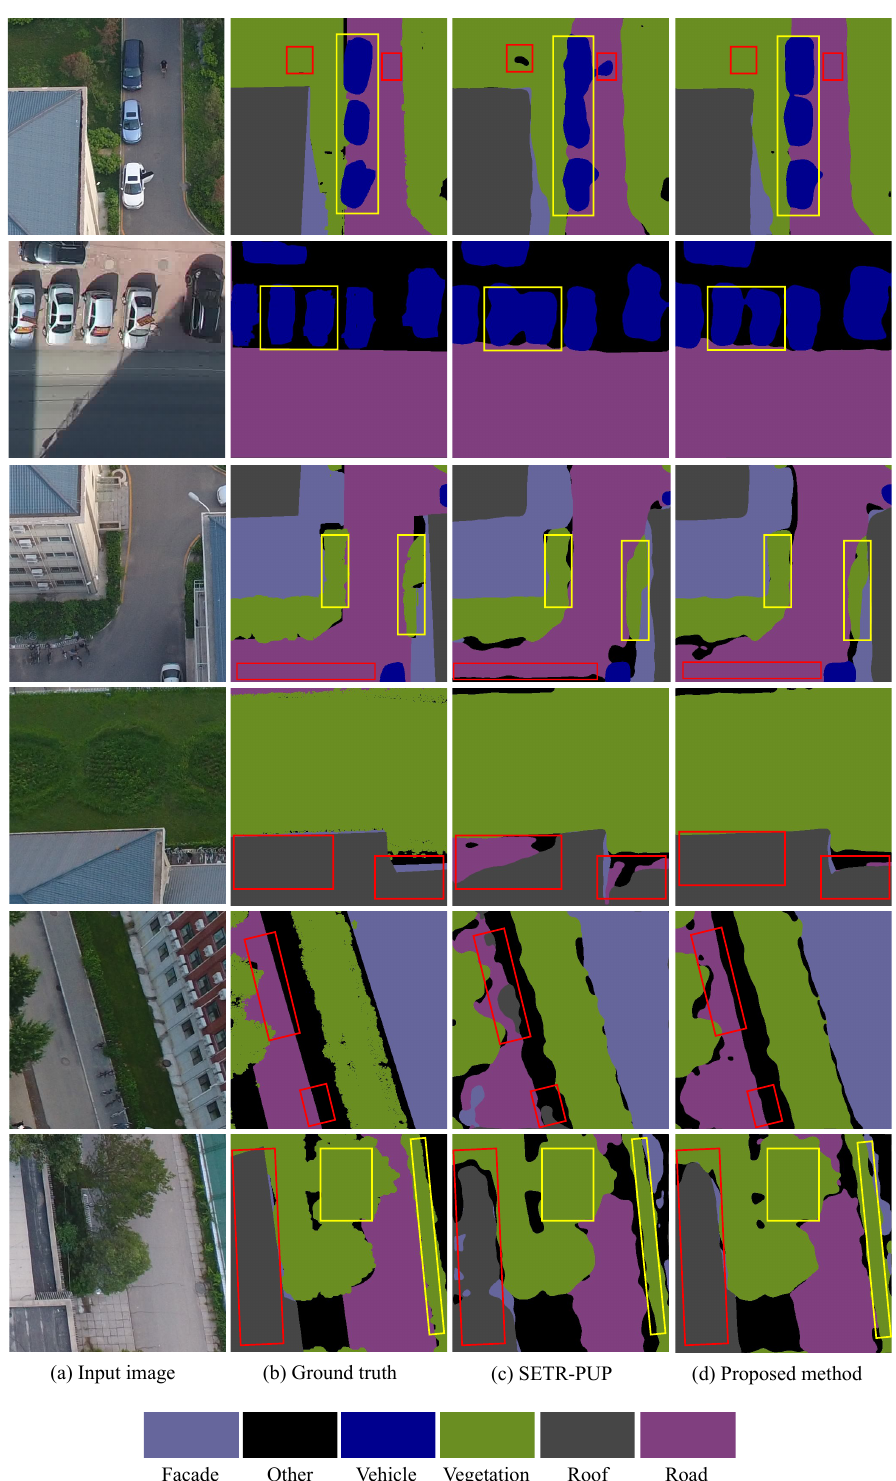
Figure 7. Qualitative prediction results using the UDD-6 validation dataset. The red and yellow boxes represent the local and global context, respectively, in the